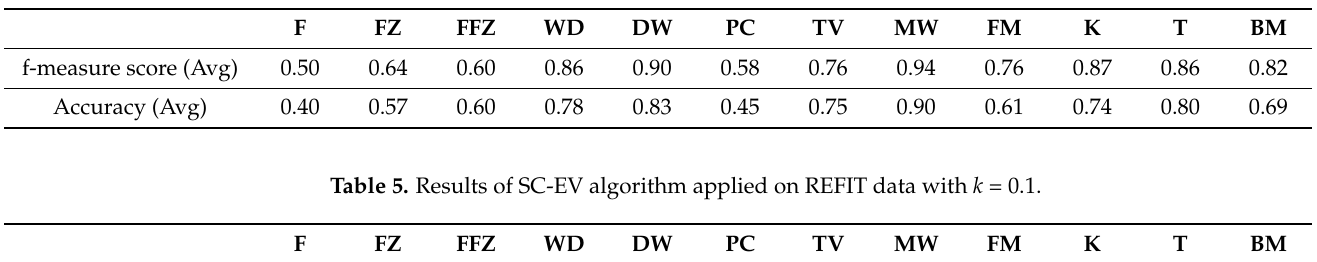
Table 4. Results of SC-EV algorithm applied on REFIT data with k = 0.01.